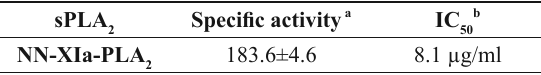
value and speci fi c activity of NN-XIa-PLA IC 50